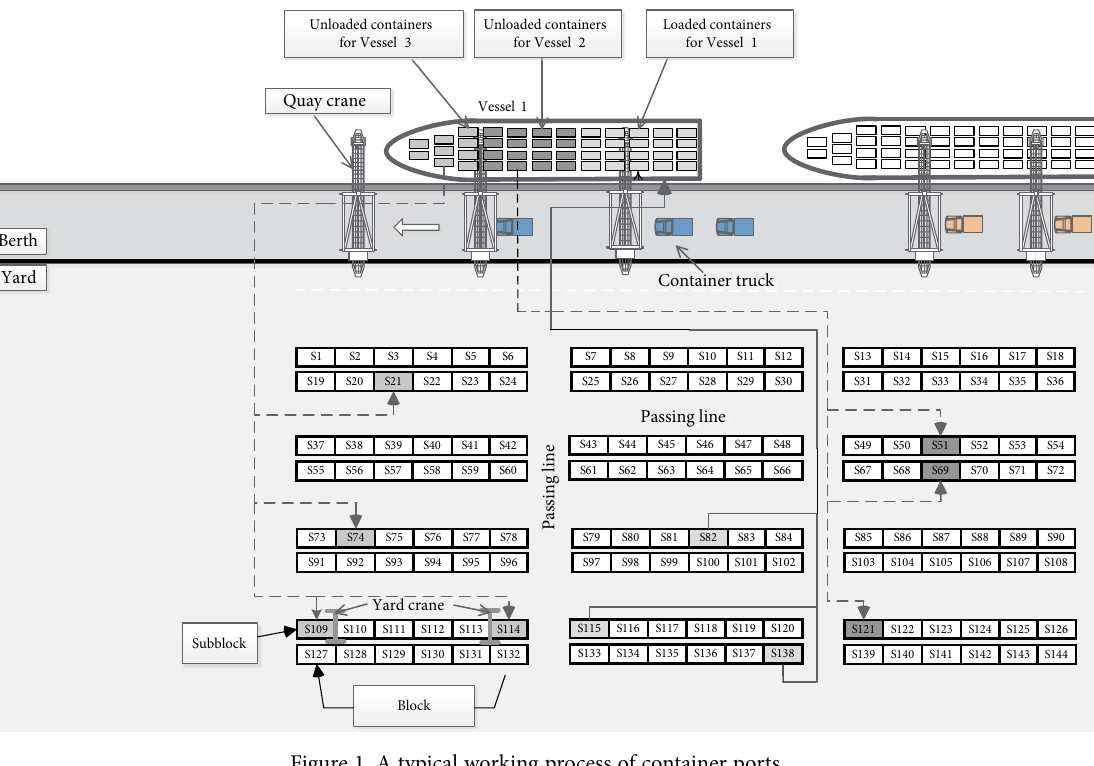
Figure 1. A typical working process of container